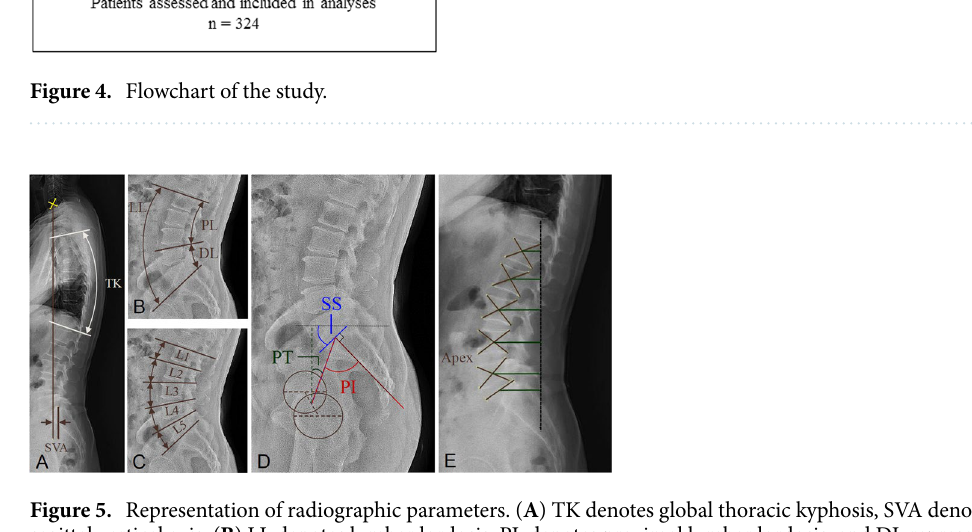
Figure 5. Representation of radiographic parameters. ( A ) TK denotes global thoracic kyphosis, SVA denotes sagittal vertical axis. ( B ) LL denotes lumbar lordosis, PL denotes proximal lumbar lordosis, and DL represents distal lumbar lordosis. ( C ) Segmental lordosis. ( D ) PI denotes pelvic incidence, PT represents pelvic tilt, and SS denotes sacral slope. ( E ) Lumbar apex. The maximum distance between the center of the vertebrae and the gravity